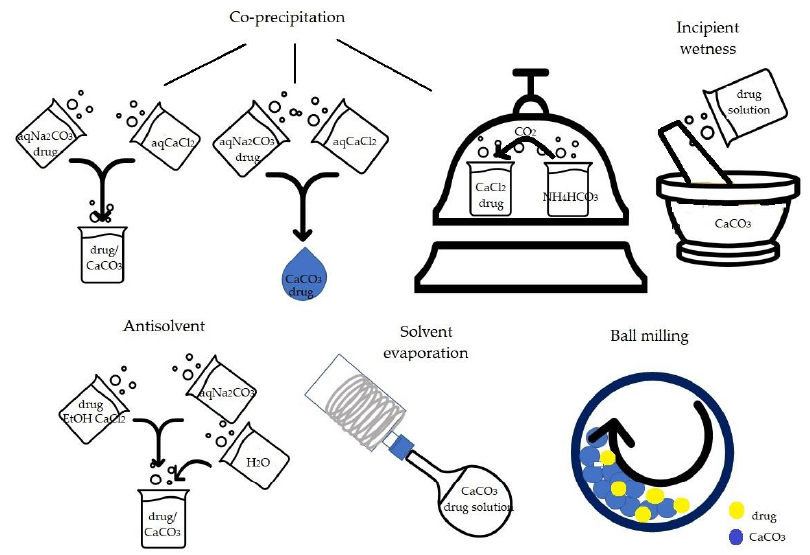
Figure 2. Schematic representation of the main procedures to obtain drug-carbonate samples. Table 1 collects different CaCO 3 forms and drugs and main methods for obtaining carbonate-drug composites. Table 1. Methods for obtaining carbonate-drug composites and main characteristics.